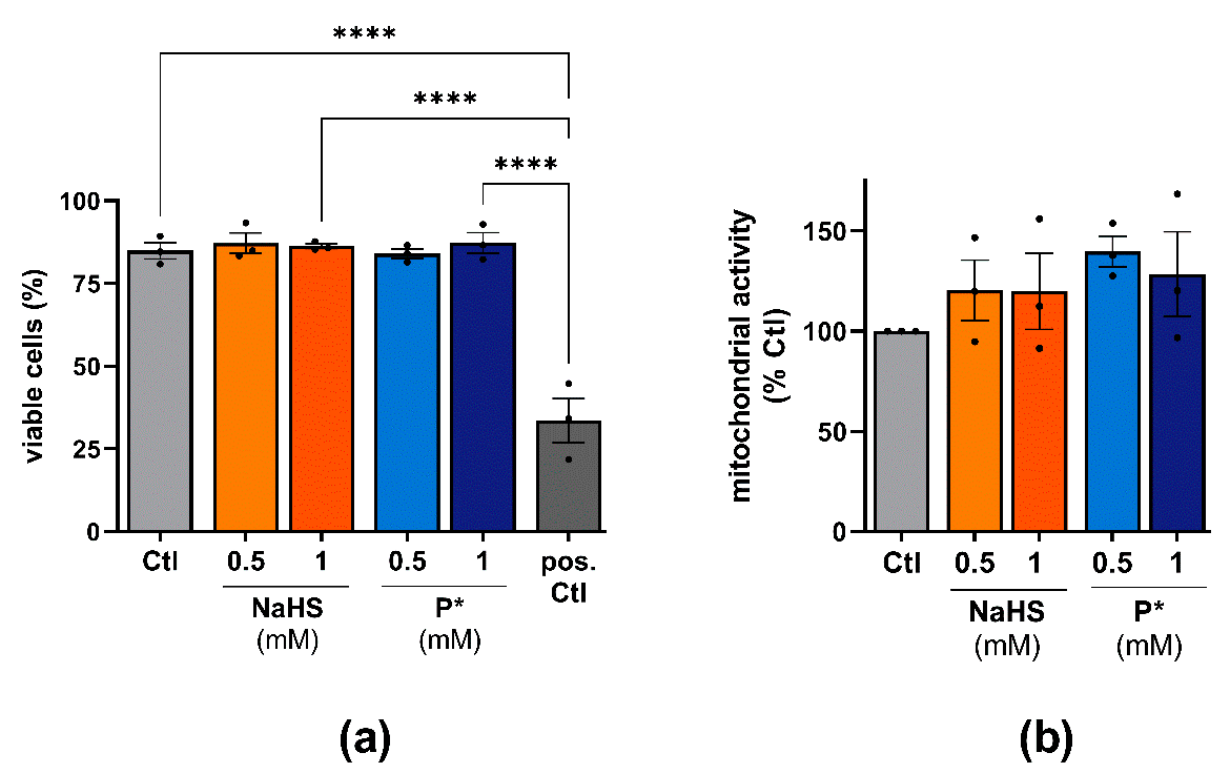
Figure 3. Effects of H 2 S donors on the cell viability of ATDC5 cells and primary human chondrocytes. ( a ) ATDC5 cells were incubated with 0.5 or 1 mM NaHS or P* for 24 h and cell viability was assessed using trypan blue staining. Untreated cells (Ctl) served as a negative control. Cells boiled for 5 min at 95 °C served as a positive control (pos. Ctl), n = 3, **** p < 0.0001. ( b ) Primary human chondrocytes were incubated for 24 h with 0.5 or 1 mM NaHS or P*. Cell viability was evaluated by MTT assay with Ctl set to 100%, n = 3.